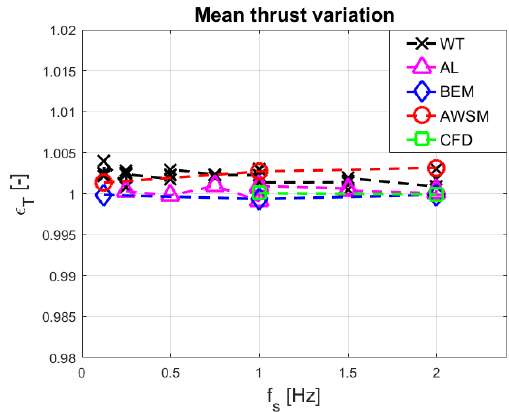
Figure 7. Mean thrust variation with the surge